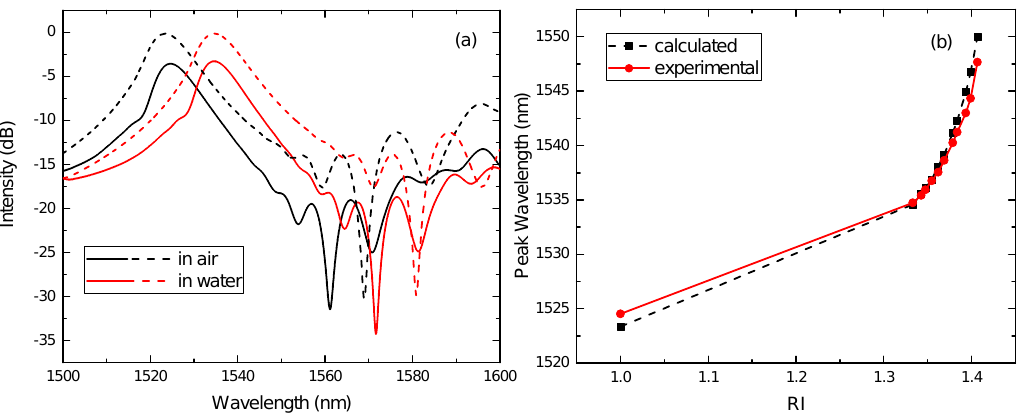
Figure 4. a NCF = 62.5 µ m and z NCF = 59mm. ( a ) The calculated and experimental transmission spectra in air and water; ( b ) the calculated and experimental peak wavelength of the SNCS structure as the cladding RI